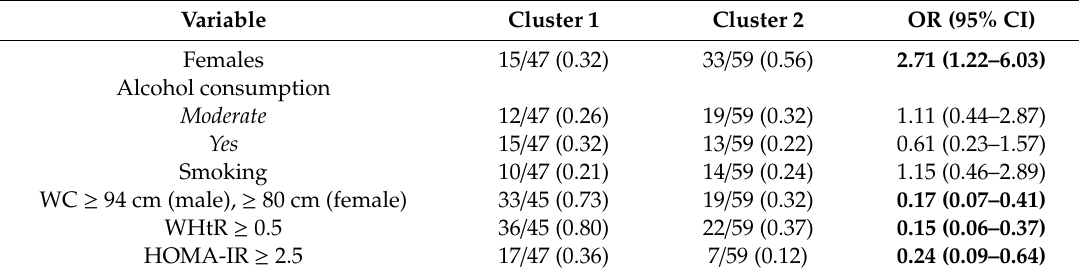
Table 3. Subjects characteristics and risk factors in the two clusters of subjects.